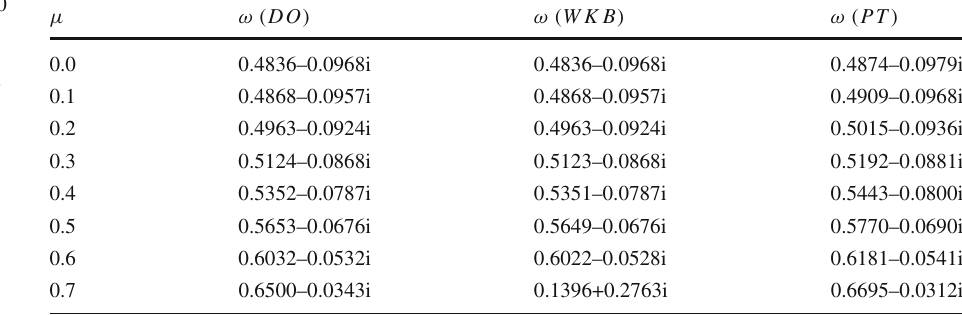
Table 4 Spin-0 QNFs for n = 0 and (cid:4) = 2 for 0 . 0 ≤ μ ≤ 0 .